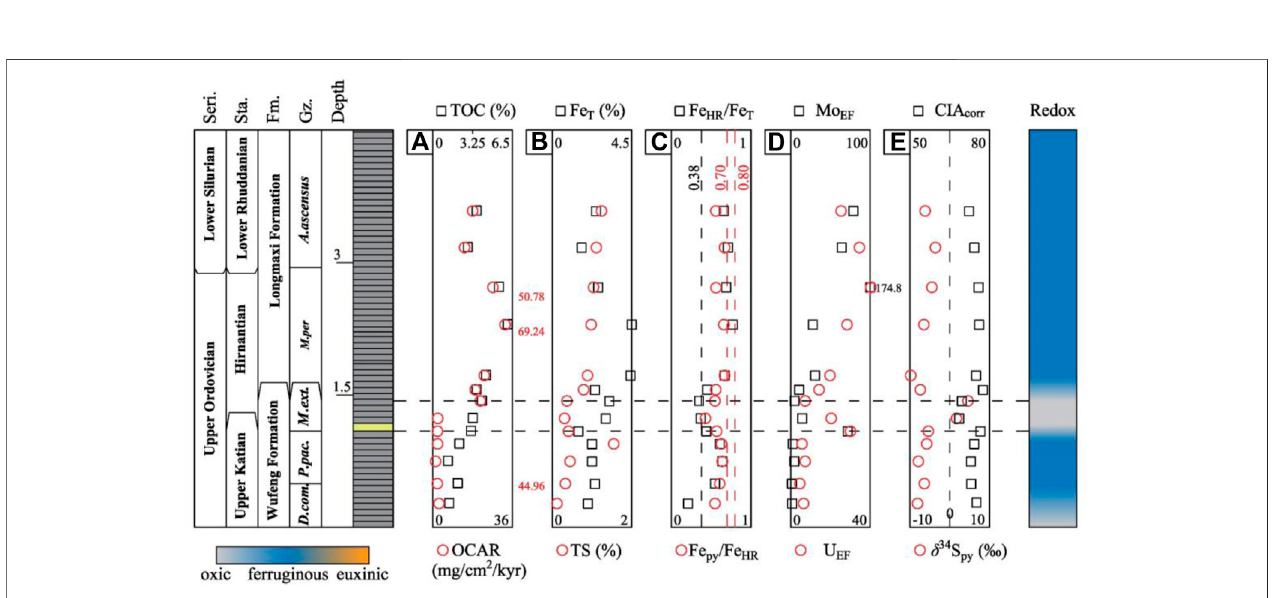
FIGURE 3 | Chemostratigraphic pro fi les of (A) TOC and OCAR, (B) Fe T and TS, (C) Fe HR /Fe T and Fe py /Fe HR , (D) Mo EF and U EF , (E) CIA corr and δ 34 S py , and the redox summary for the Changhebian section. The vertical dotted line represents the threshold of each proxy. Abbreviations as in Figure 1 .